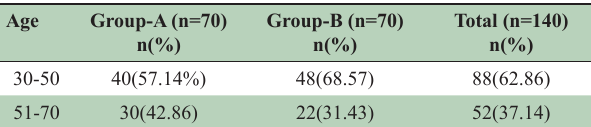
p≤0.05 is considered statistically significant. Comparison of frequency of hypoparathyroidism in study